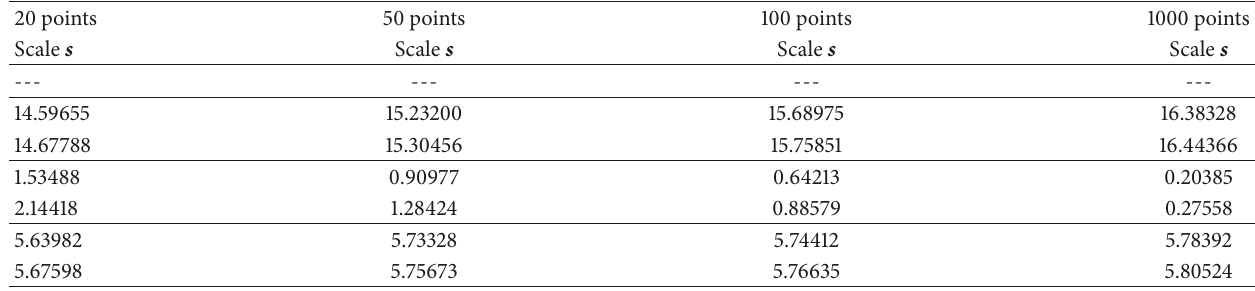
Table 11: Log-normal distributions with 30% noise level.